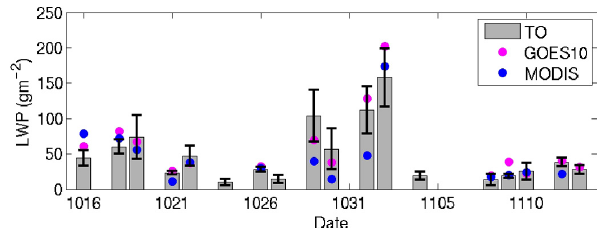
Fig. 10. LWP integrated from aircraft soundings on all flight days. The estimated errors in LWP from Eq. (5) are indicated by the error bars. Magenta symbols are GOES retrievals averaged for each en- tire flight mission over an area within a radius of 20km of Point Alpha. Blue symbols are average Terra MODIS retrievals for a 0.5 ◦ region centered on Point Alpha taken at between 14:20 and